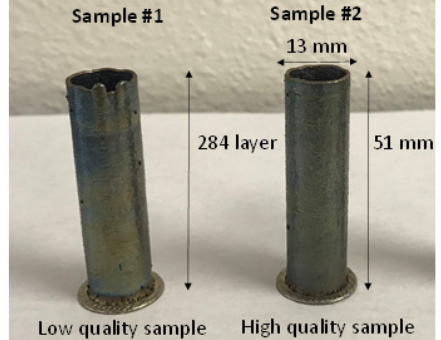
Figure 2. Inconel 625 sample hollow cylinders.